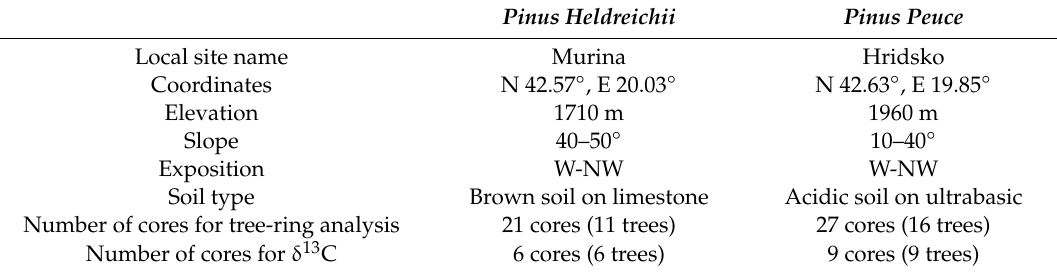
Figure 1. Locations of Hridsko and Murina sites (black triangles) with the species distribution range for P. peuce (blue) [27] and P. heldreichii (red) [26]. Table 1. Site characteristics and sample